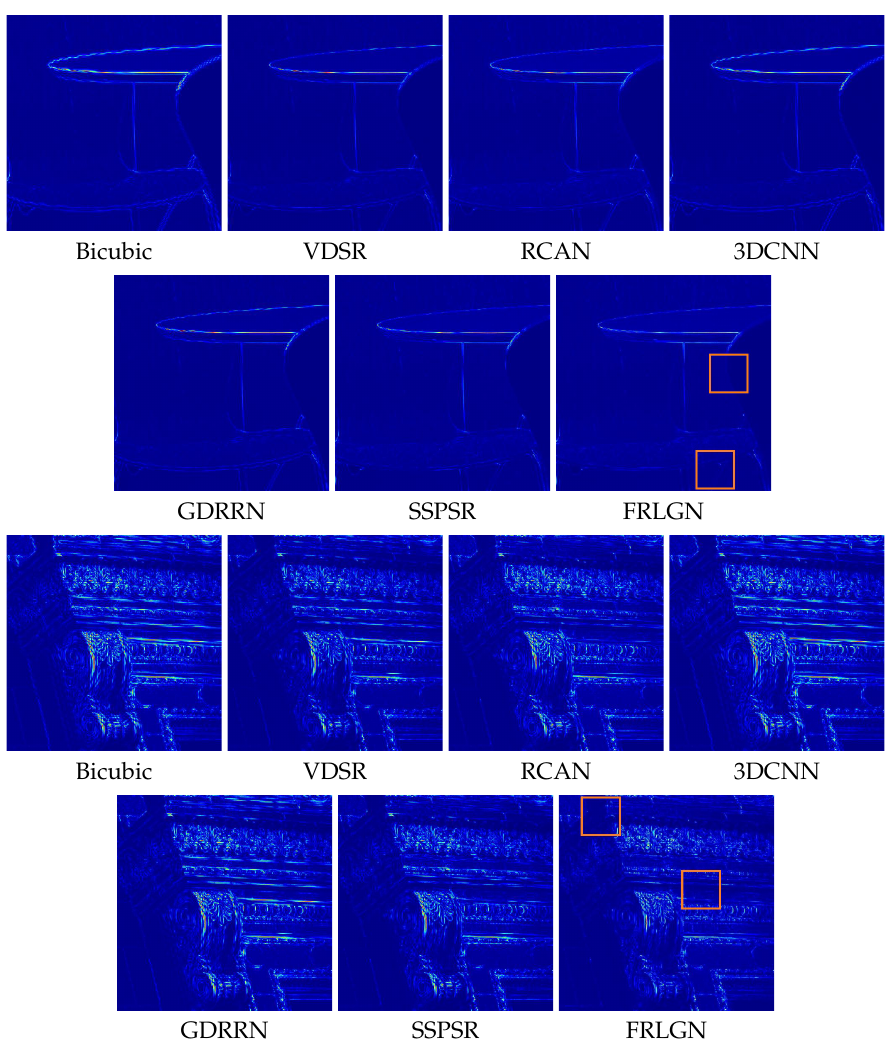
Figure 5. Mean error maps of two hyperspectral images from the Harvard testing dataset with the scale factor 4.